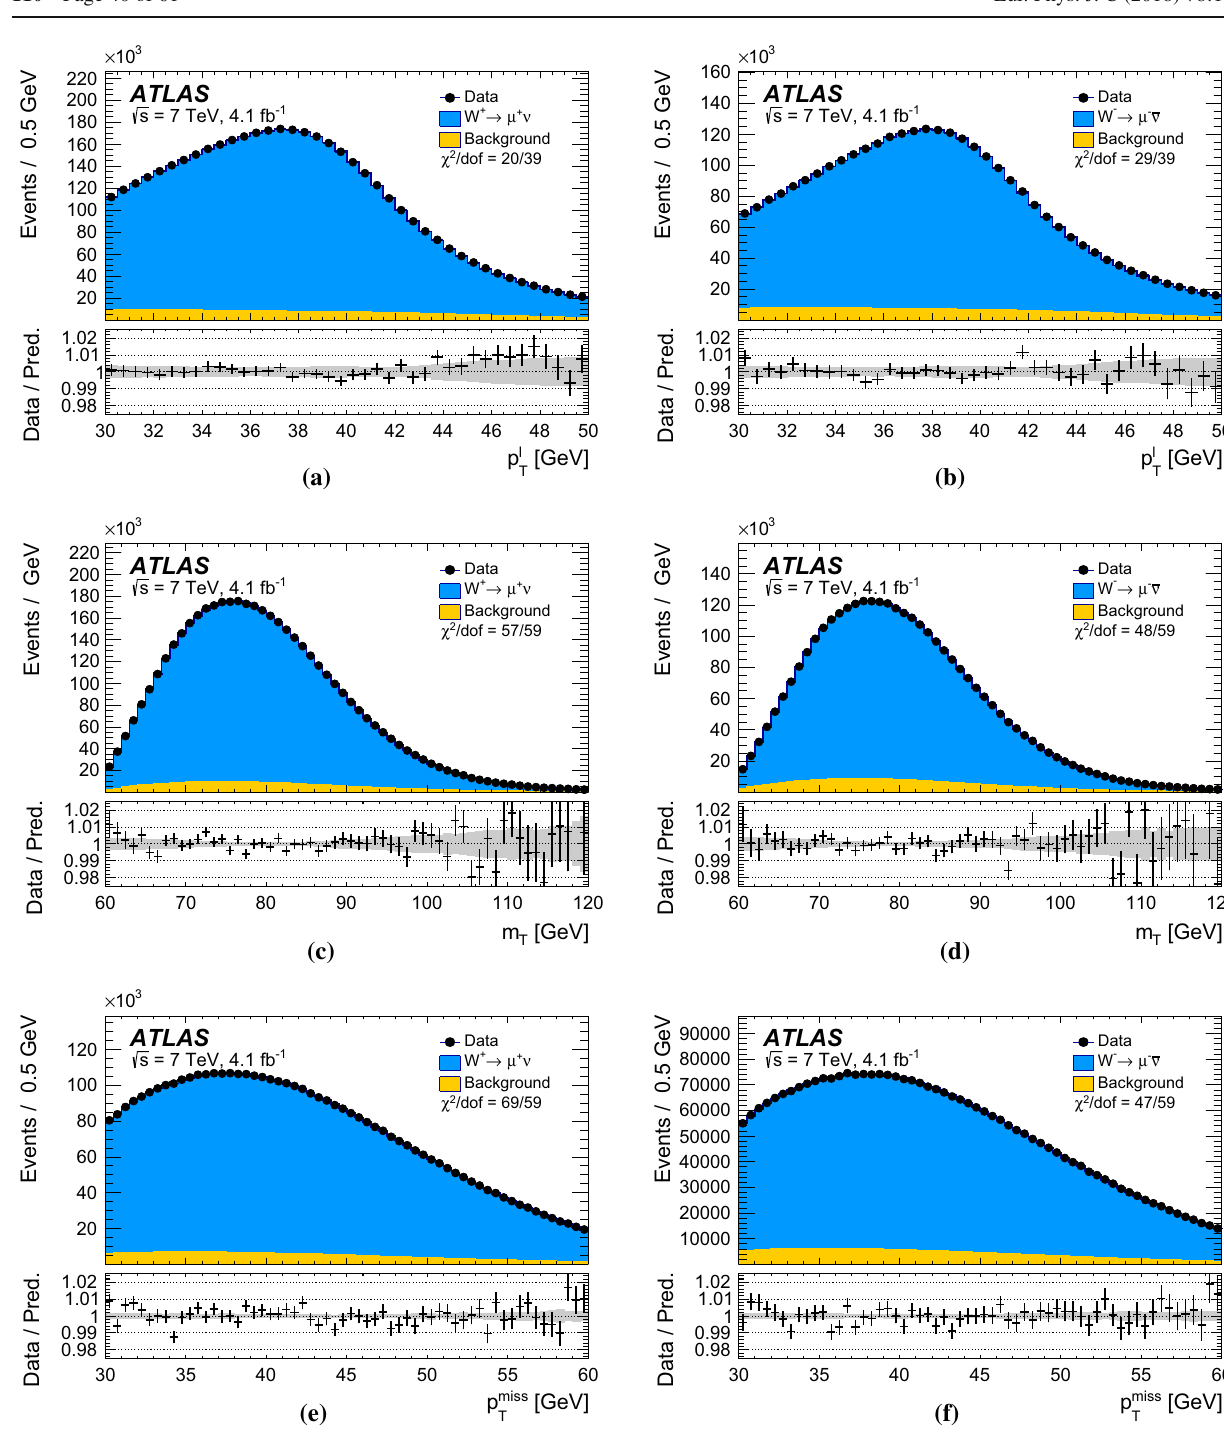
Fig. 25 The a , b p (cid:7) the data-to-prediction ratios, the error bars show the statistical uncer- , c , d m T , and e , f p miss distributions for a , c , e T T W + events and b , d , f W − events in the muon decay channel. The data tainty, and the band shows the systematic uncertainty of the prediction. The χ 2 values displayed in each figure account for all sources of uncer- are compared to the simulation including signal and background con- tributions. Detector calibration and physics-modelling corrections are tainty and include the effects of bin-to-bin correlations induced by the applied to the simulated events. For all simulated distributions, m W is systematic set according to the overall measurement result. The lower panels show